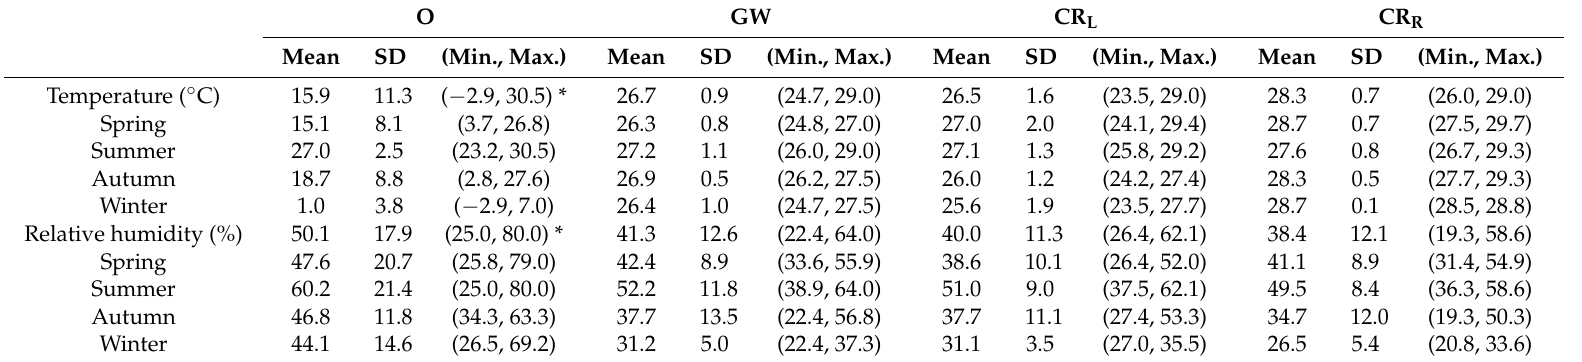
Table 1. Temperature and relative humidity profile at each location and by